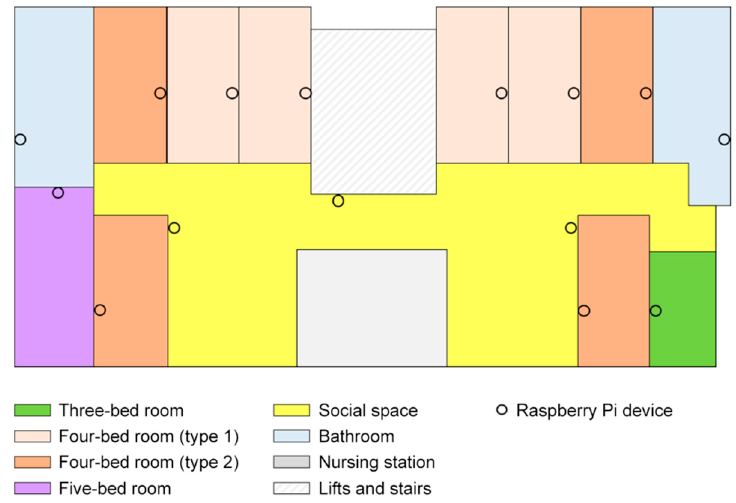
Figure 3. Typical unit floor plan with sensors. The figure shows a typical floor of a unit. Different colours represent the type of space in the home, e.g., social space, three-bed rooms, two types of four-bed rooms (type 1 faces the corridor, type 2 faces social space).